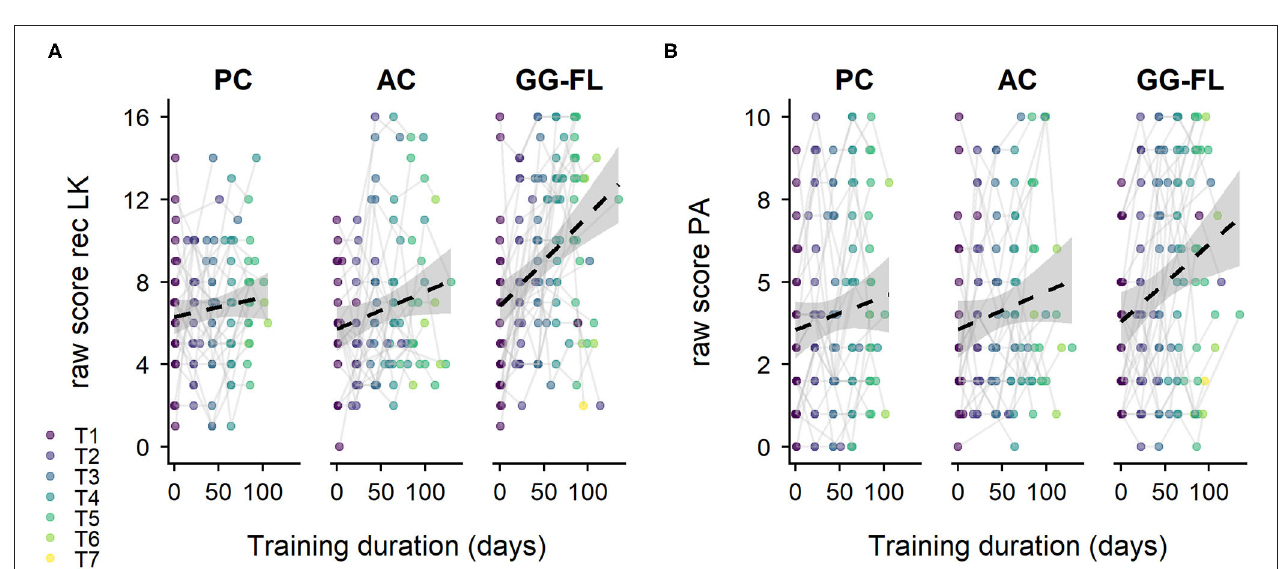
FIGURE 4 | Specifically trained decoding-related skills—pre- and post-test assessments. (A) , Distribution of productive letter knowledge scores across groups and timepoints, (B) , Distribution of word decoding scores across groups and timepoints. LK, letter knowledge; DMT, (Drie-Minuten-Toets, English: Three-Minute Test); PC, passive control group; AC, active control group; GG-FL, GraphoGame Flemish group. Black dots represent the mean of the raw scores.